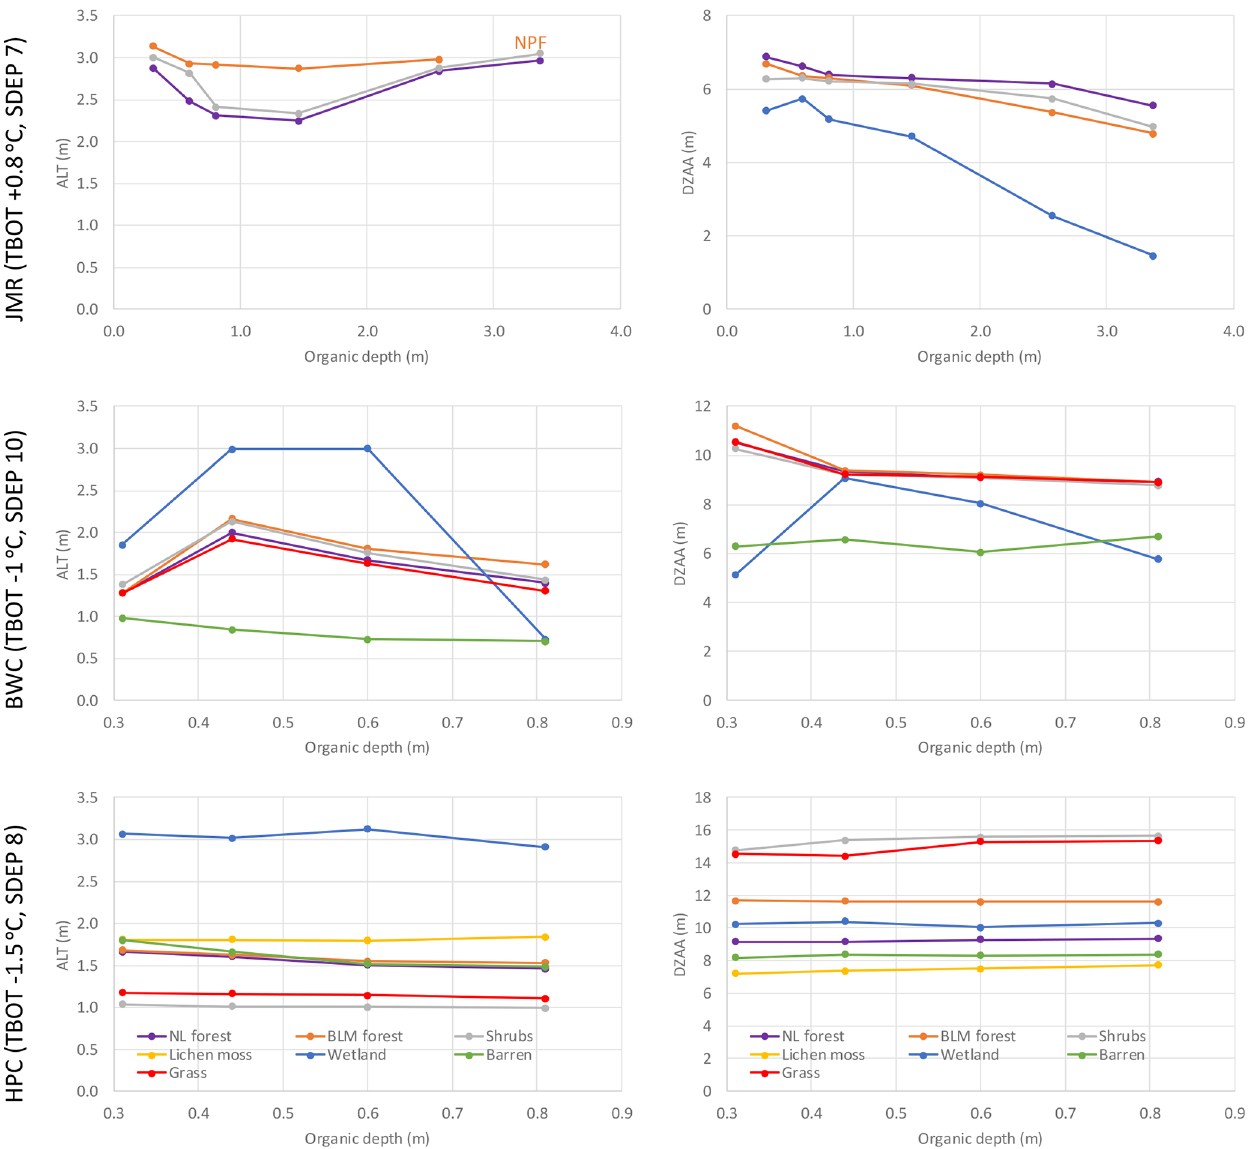
Figure 16. Impact of the depth of organic soil layers on the average simulated ALT and DZAA for different GRUs at the three study sites for the 1980–2016 period. NPF: no